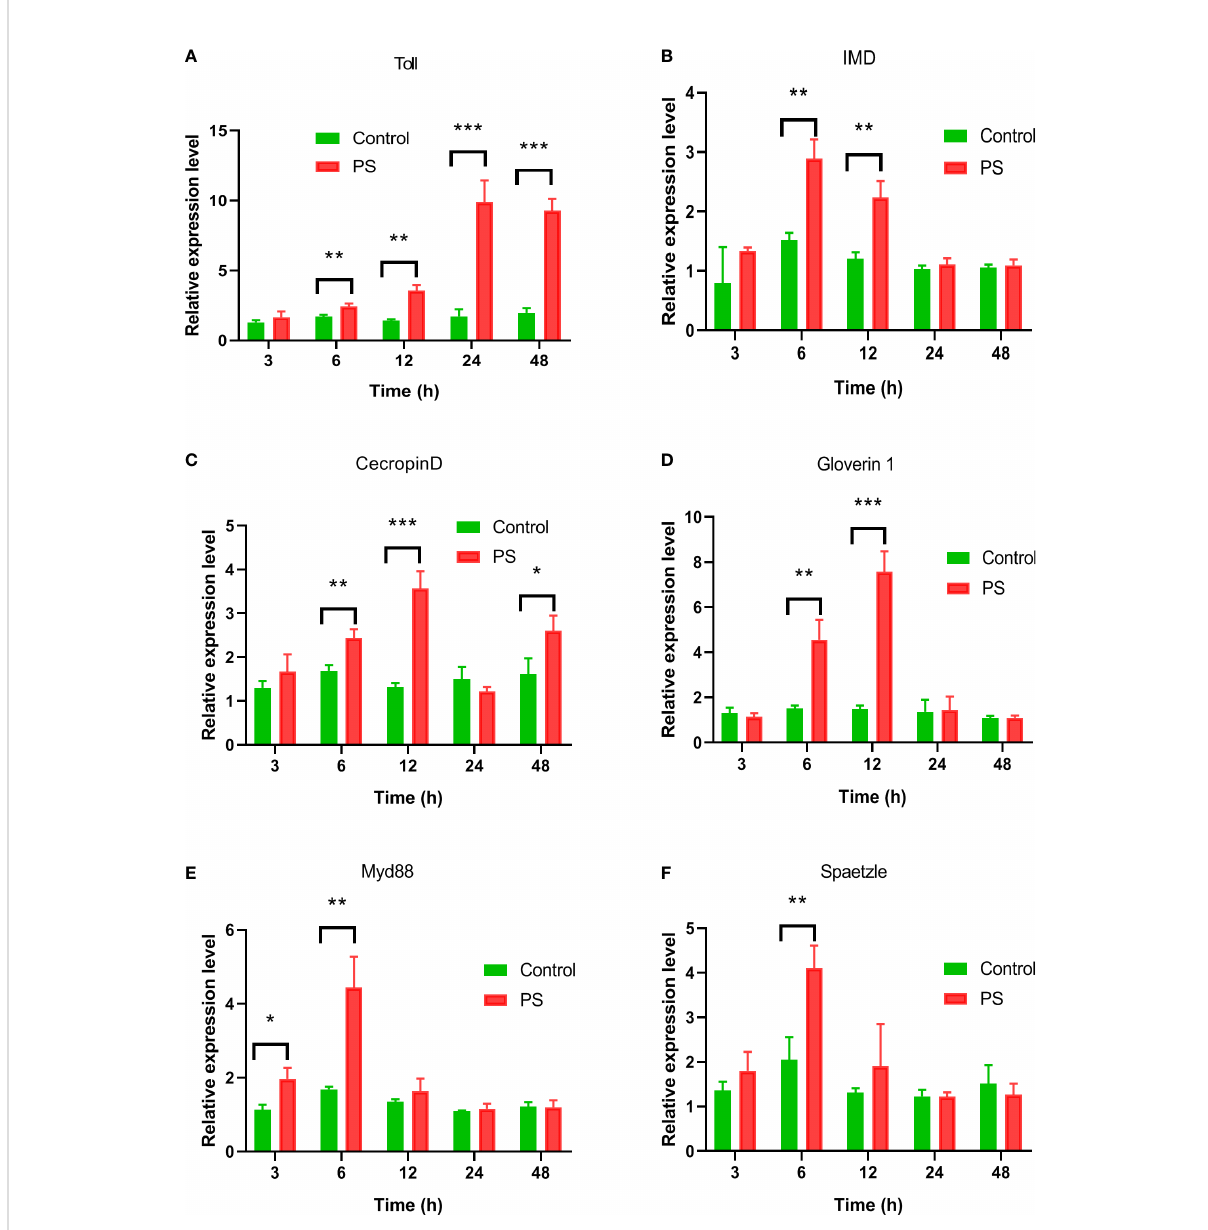
FIGURE 6 The expression pro fi les of genes involved in IMD, or Toll pathway induced by Poria cocos polysaccharides (PS). After the hemocoel injection of Bombyx mori larvae with PS (0.2 m g/larva), the mRNA levels of (A) Toll, (B) Imd, (C) Ceceropin D, (D) Gloverin1, (E) Myd88, and (F) spaetzle were detected by qRT-PCR. Two-way ANOVA/Tukey was conducted for statistical analysis. Asterisks indicate the levels of signi fi cant differences (* P < 0.05, ** P < 0.01, *** P <